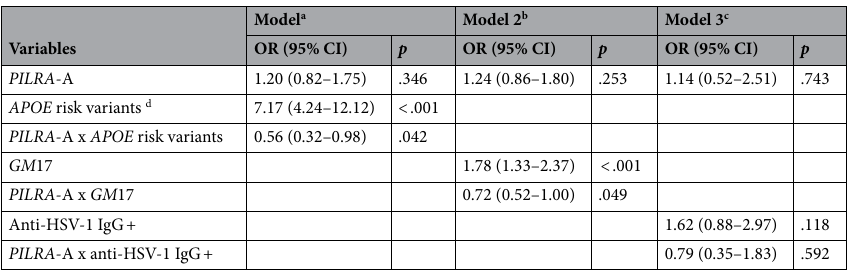
Table 3. Conditional logistic regression of Alzheimer’s disease risk with interactions of PILRA R78G-A, APOE risk variants, GM 17/17 and anti-HSV-1 IgG +. OR Odds ratio, CI Confidence interval, APOE apolipoprotein E. a Interaction model: PILRA R78G-A x APOE risk variants. b Interaction model: PILRA R78G-A x GM 17. c Interaction model: PILRA R78G-A x anti-HSV-1 IgG +. d Genotype ε3/ε4 or ε4/ε4.